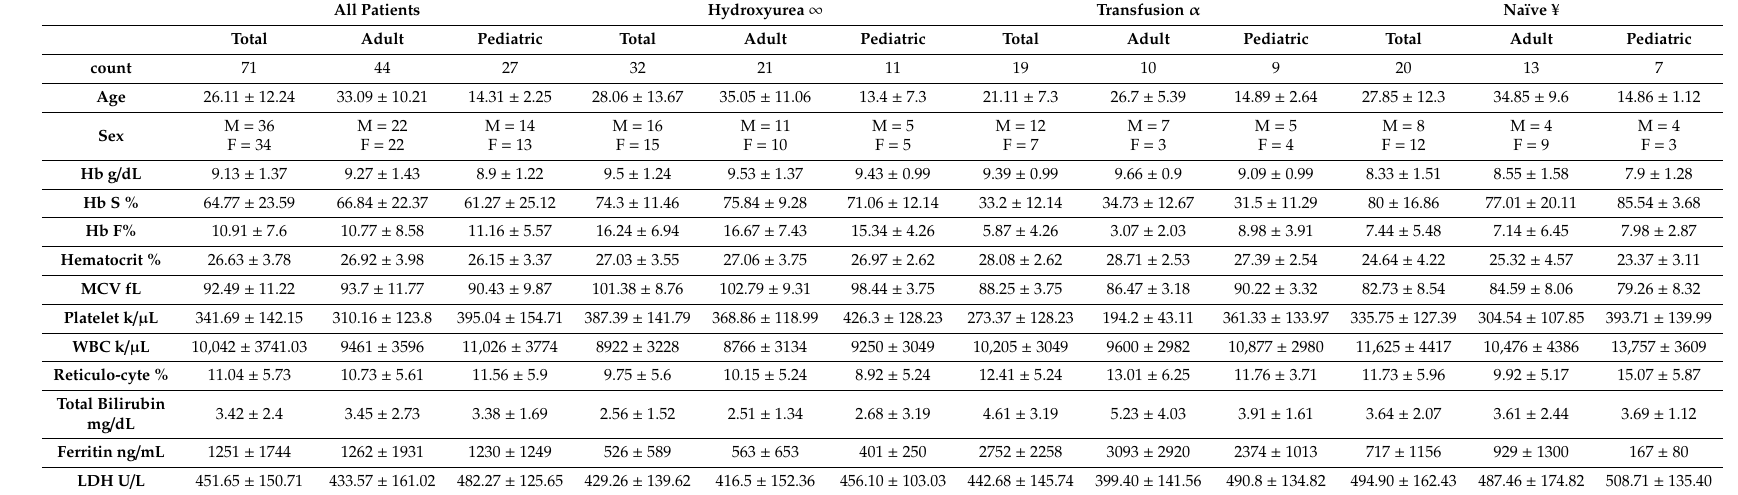
Table 1. Clinical and laboratory